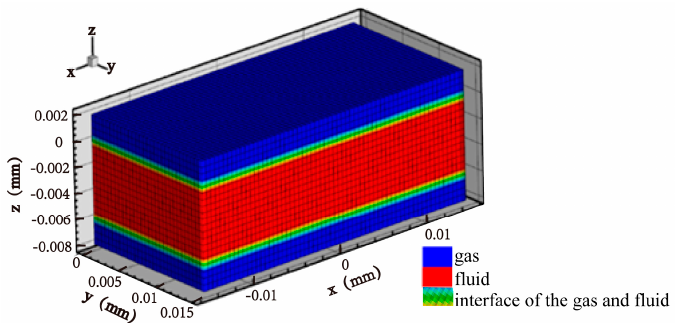
Figure 5. Computational domain for VPPAW model.